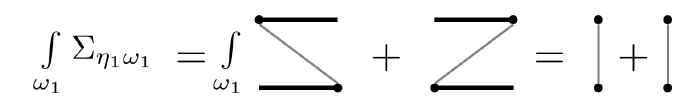
[ σ ] , cf. Fig. 10(b). Due to the energy , σ 1 0 1